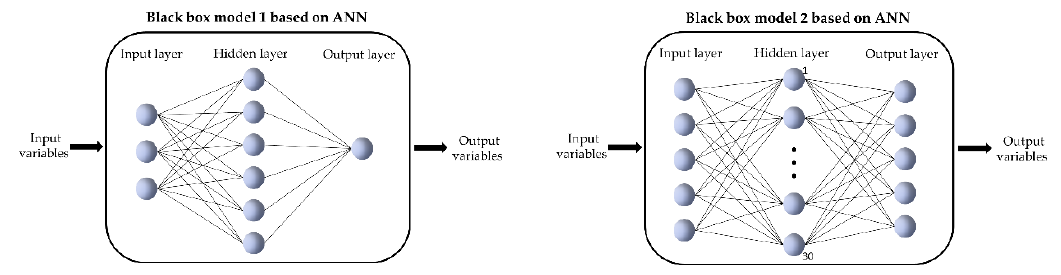
Figure 9. Variation in mean squared error with the number of hidden neurons.